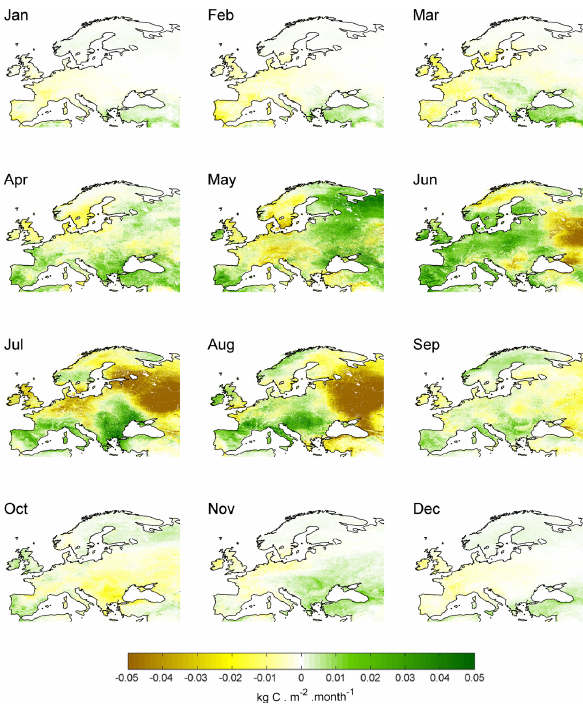
Figure 5. Monthly PsN anom fields from MOD17A2 during 2003.